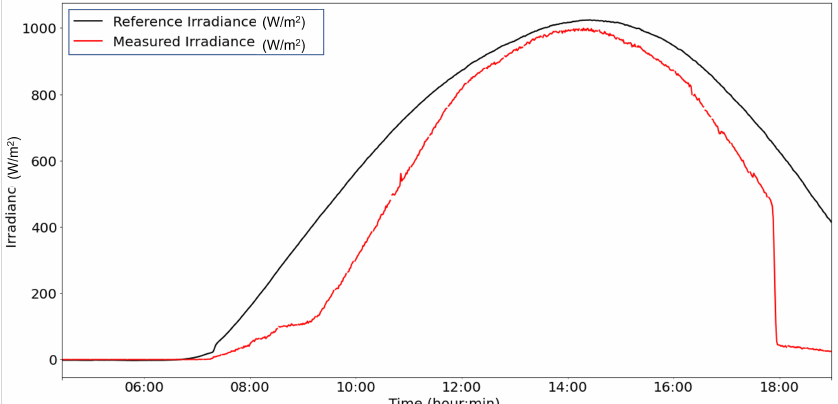
Figure 15. Example of collected current data: PV module monitored.